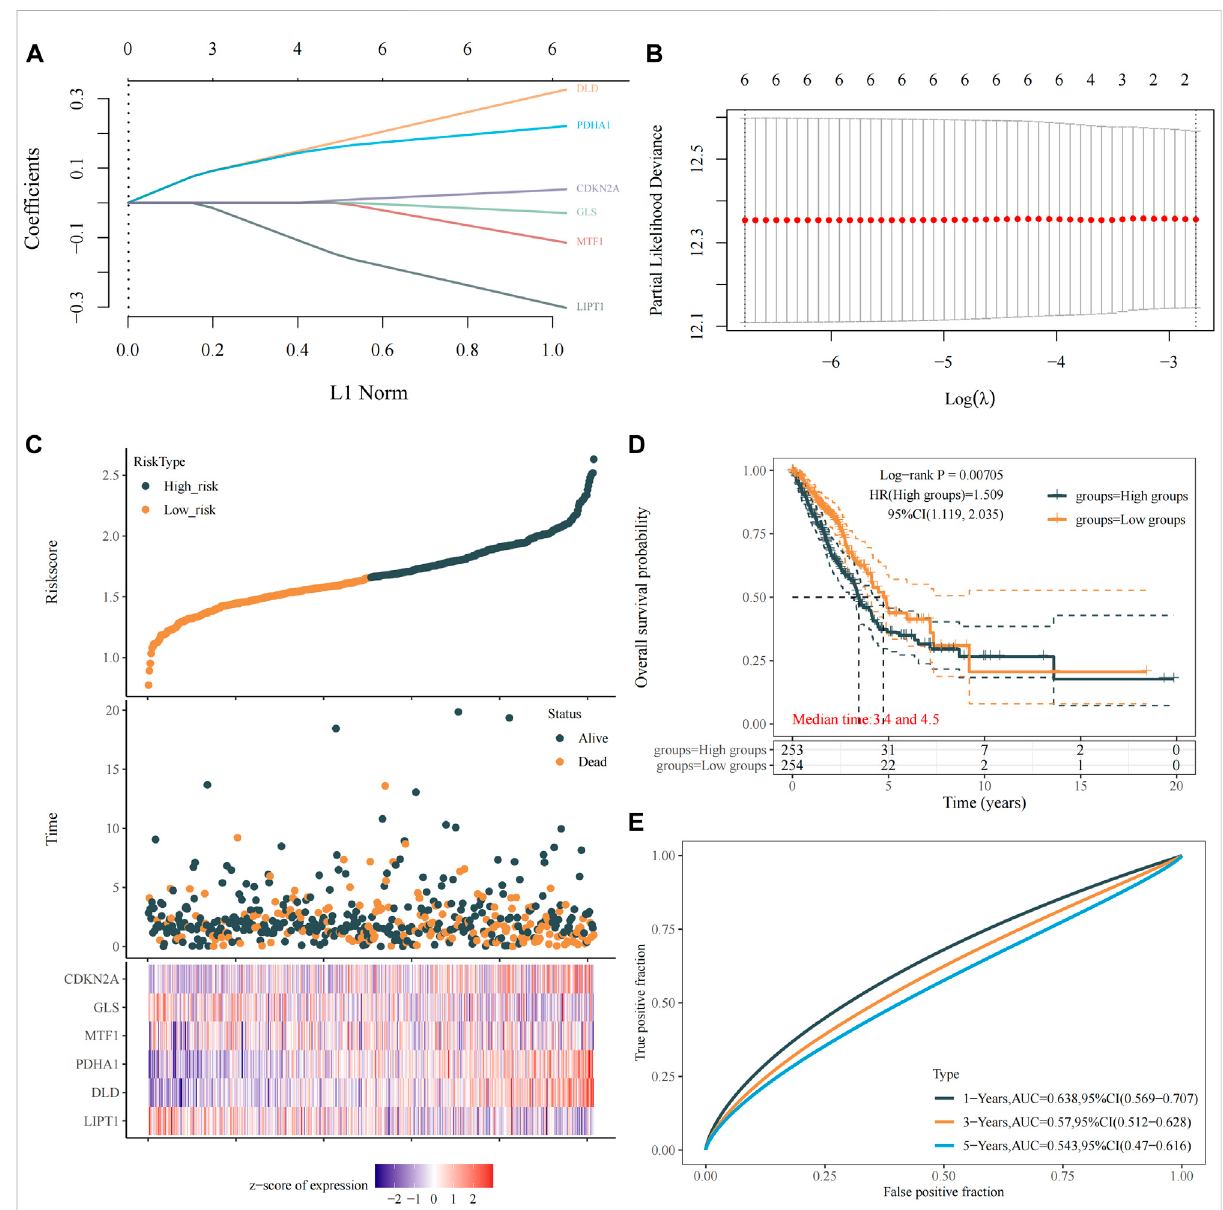
FIGURE 4 ConstructionofaprognosticsignaturemodelofCRGsinLUAD. (A) LASSOcoef fi cientsofthesixprognosticCRGs. (B) PLDofthesixprognostic CRGs. (C) Distribution ofriskscore,survival status,andexpressionofthesixprognosticCRGs. (D) OScurveofpatientswithLUADinthelow andhigh expression groups. (E) 1-, 3-, and 5-year ROC prediction curves for patients with